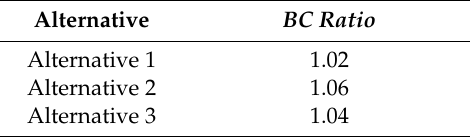
Table 6. Benefit–cost ratio ( BC Ratio ).